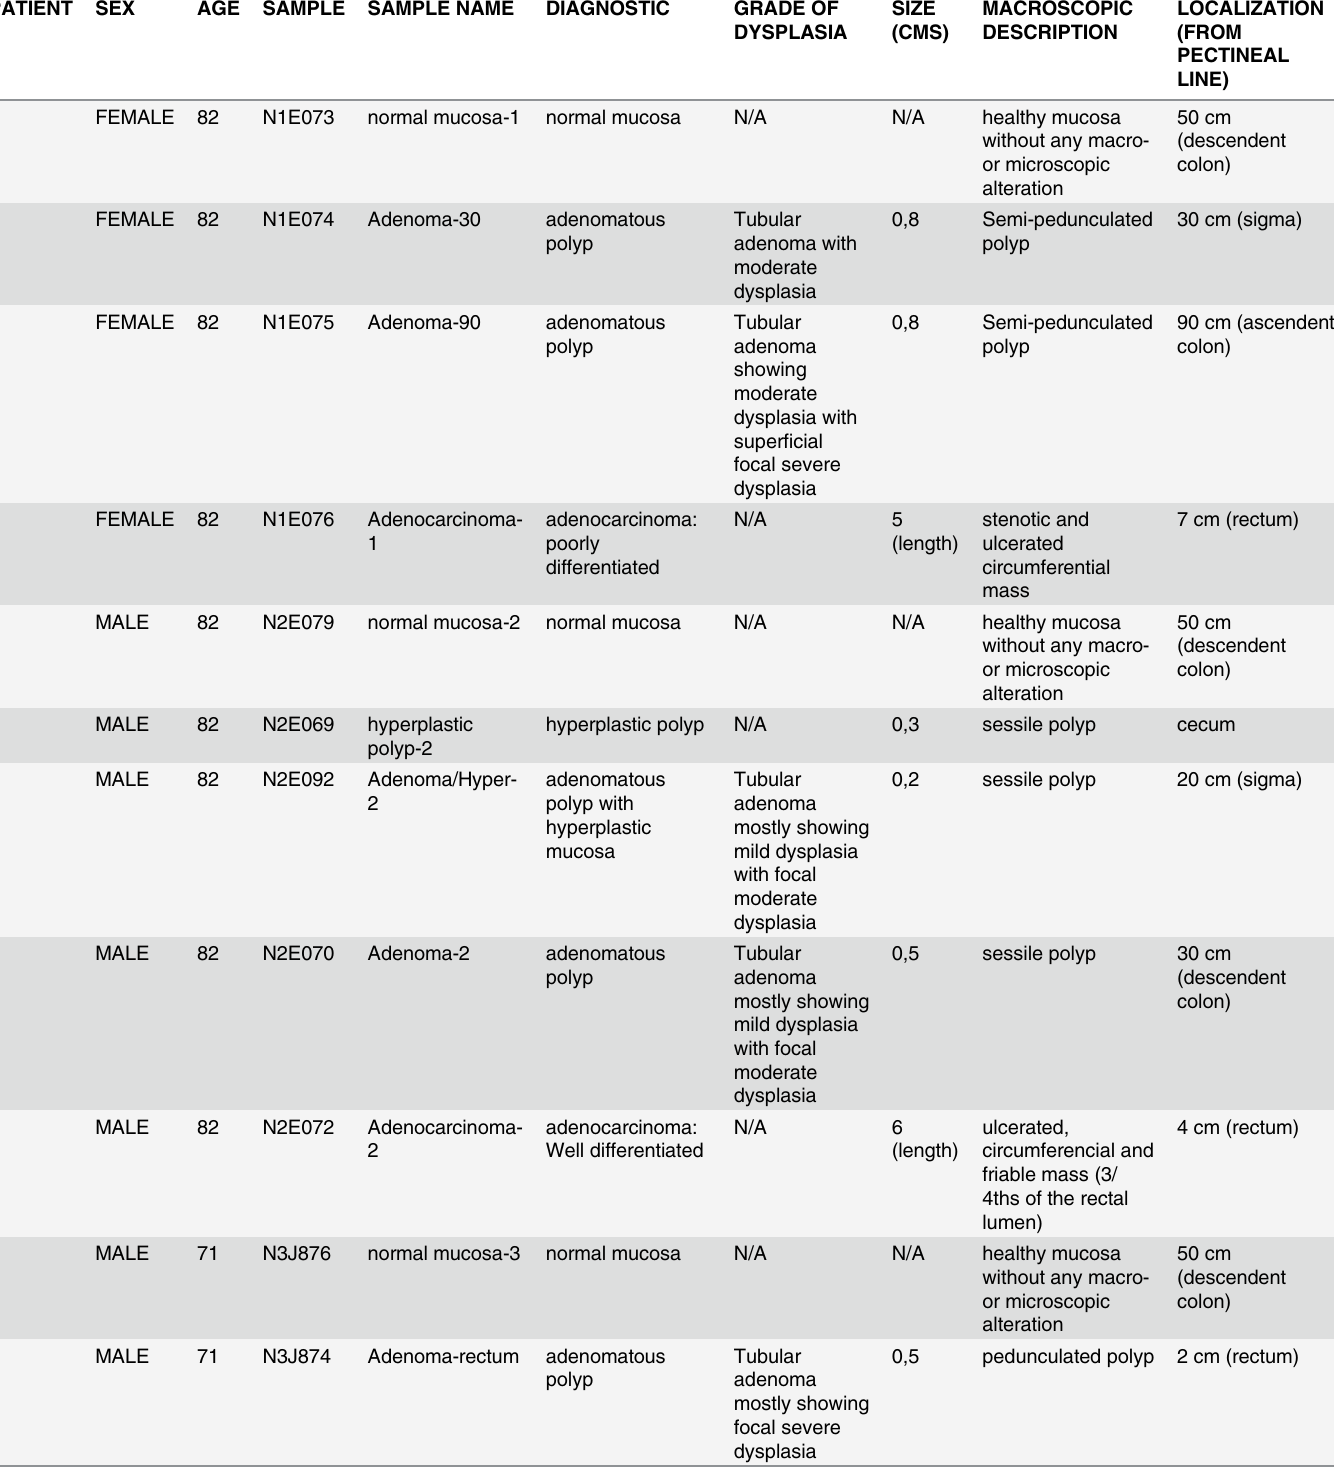
Table 1. Clinical description of the samples